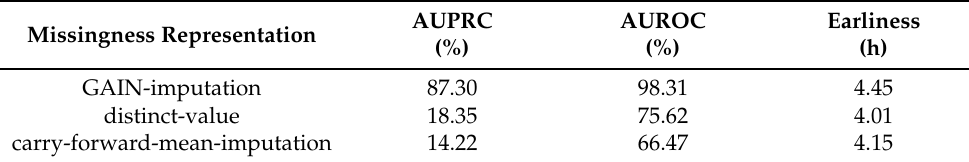
Table 5. Evaluation results using non-text input features in single-server setting.